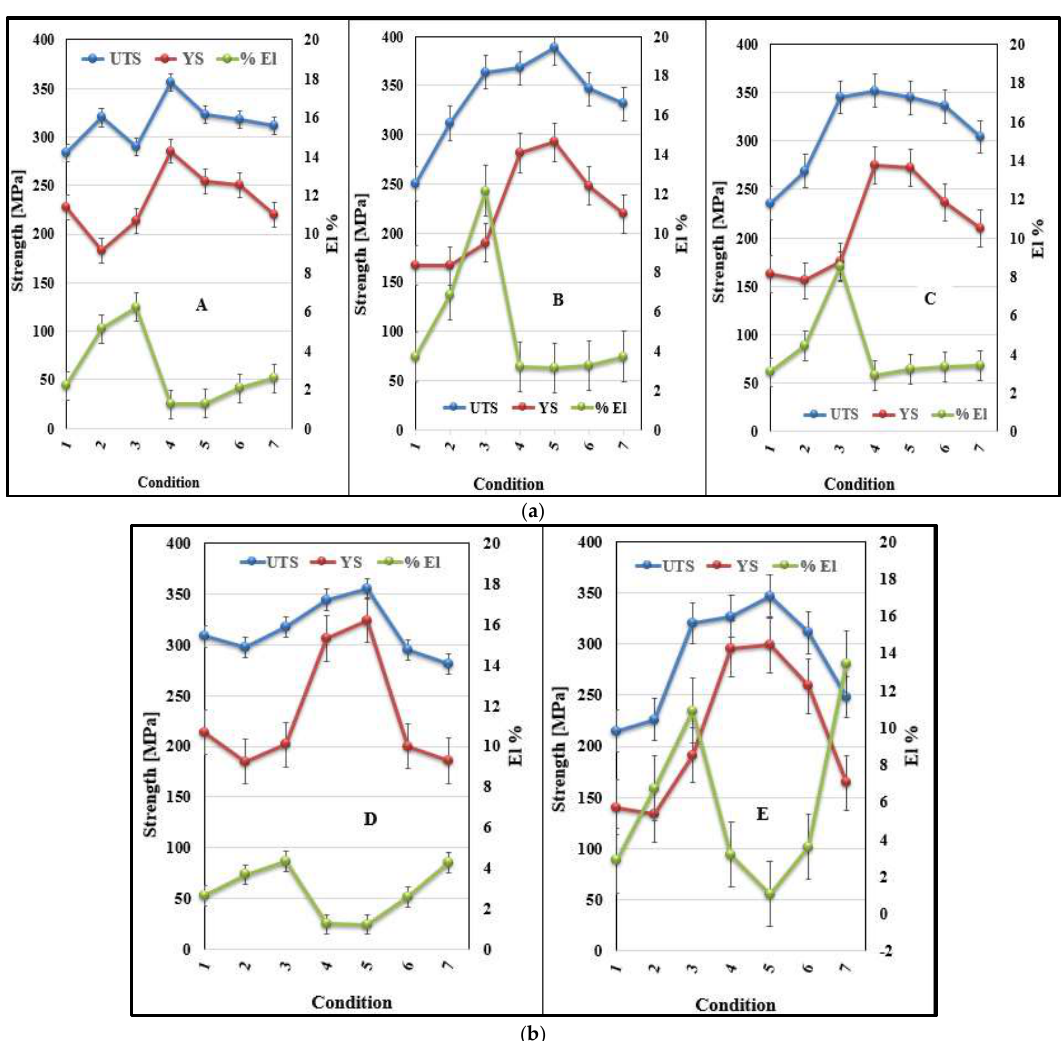
Figure 5. Variation in the tensile properties as a function of the heat treatment and alloy composition: ( a ) three versions of the T200 alloy; ( b ) commercial alloys. Figure 6 is a schematic diagram showing the effect of the heat treatment on the dis- location motion and particle density of the alloy strength when going from the T6 to T7 condition. Abdelaziz et al. [17] investigated the dislocation-particles interaction as a func- tion of heat treatment in the 354 alloy, as depicted in Figure 7, using transmission electron microscopy. In the case of the present alloys, Figure 8 exhibits the variation in the precip- itates as a function of the applied heat treatment.